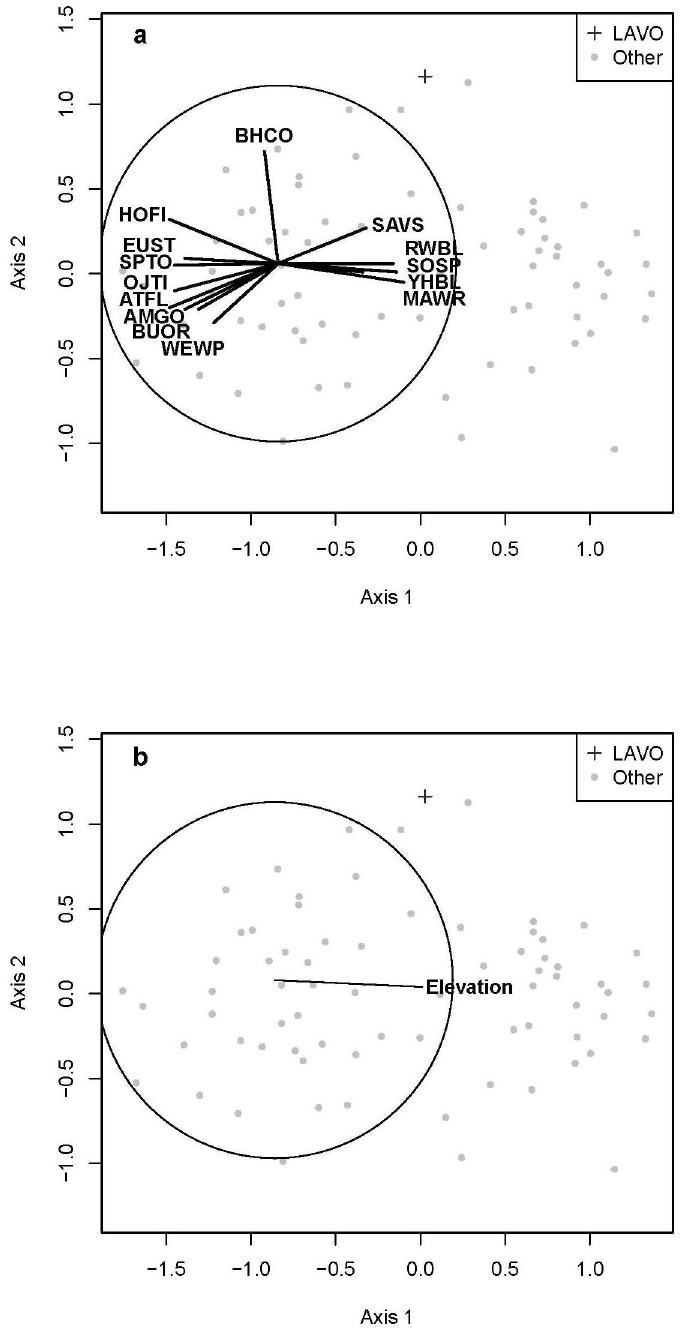
Fig 2. Bird Communities and Environmental Variables in Agriculture Habitat. Relationship of individual bird sites (displayed by park unit) identifiedas agriculturehabitat (see text) using Non-metric Multidimensional Scaling. Biplots are direction and relative strength of Pearson correlationcoefficients (the circle indicates a correlationof 1) between bird sites and (A) underlyingbird species with a rho of > 0.5 and (B) environmental variables that maximized the overall correlationthrough BIOENV (Table 4). See S1 Table for bird codes and S2 Table for definitions and abbreviations of environmental